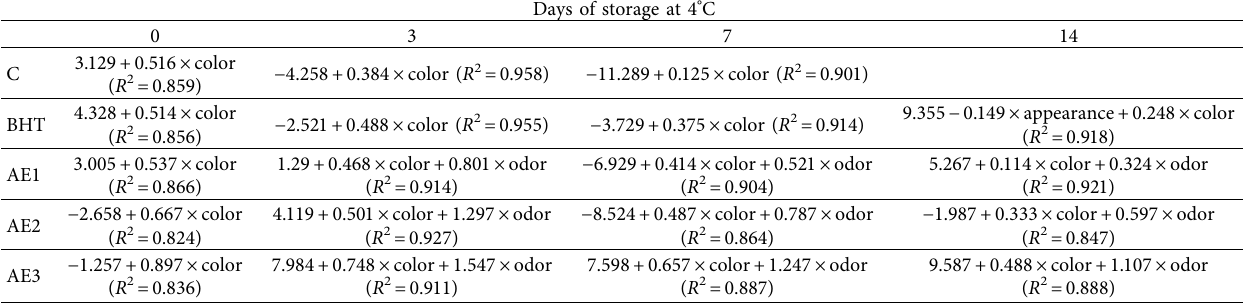
Table 6: Multiple linear regression equations of overall acceptability versus sensorial parameters of raw minced beef meat stored at 4 °